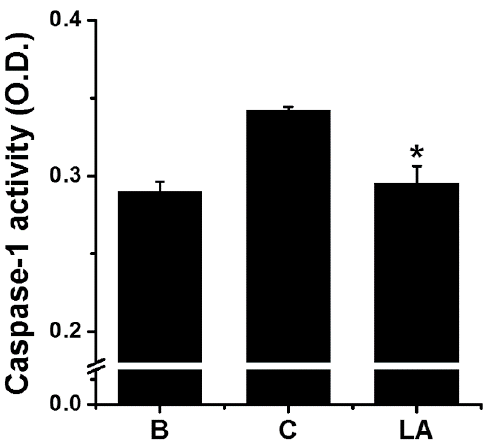
Figure 4. Effect of LA on the caspase-1 activation in HMC-1 cells. HMC-1 cells (5 × 10 6 ) were pretreated with LA for 1 h, and then stimulated by PMA plus A23187 for 1 h. Each protein level was quantitated by densitometry. B, PBS-treated cells; C, PBS-treated, and then PMA plus A23187-stimulated cells. Each datum represents the mean ± S.E.M. of three independent experiments. * p < 0.05; significantly different from the control (PBS-treated, and then PMA plus A23187-stimulated cells) value.